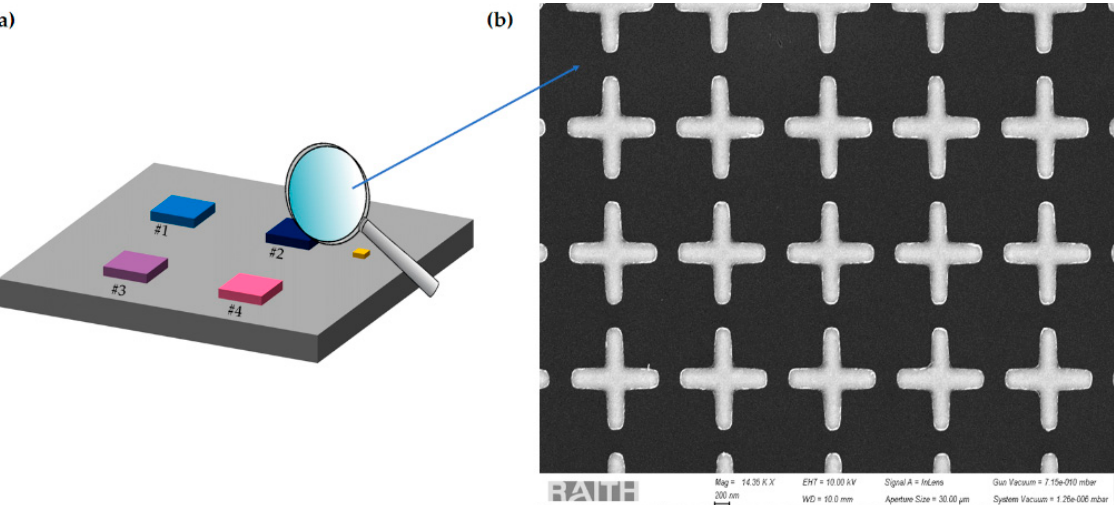
Figure 3. ( a ) Schematic of the proposed MS. Pixels are identified by a unique number; ( b ) SEM image of pixel #2.